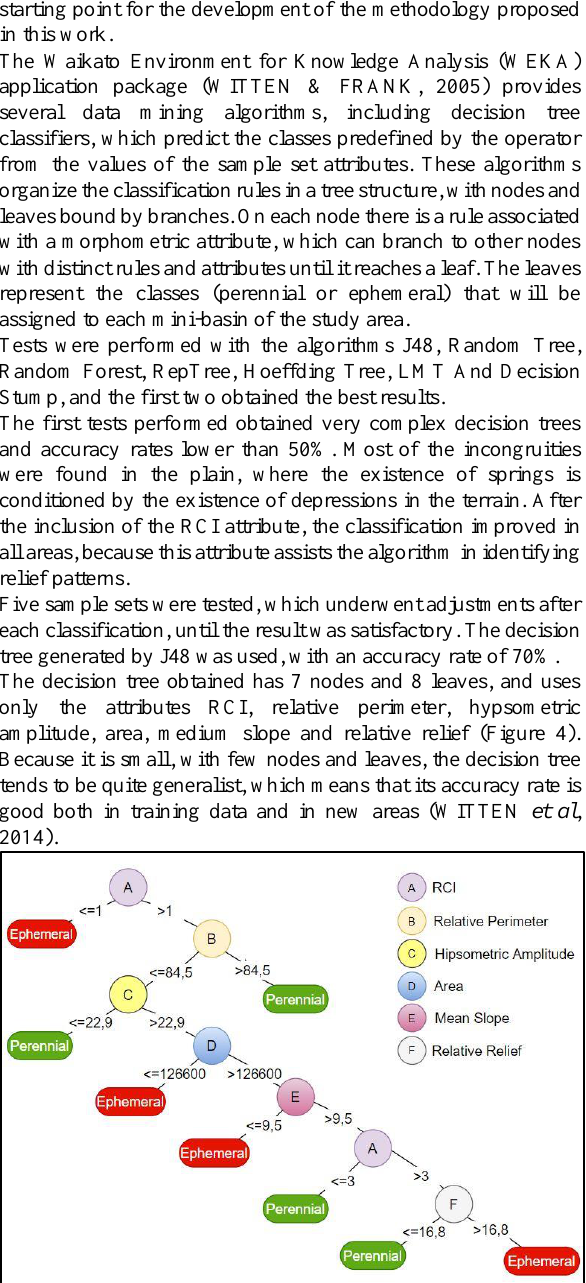
Table 1: Morphometric attributes used in the data mining process, extracted from the DEM of the study area (SDS, 2011).